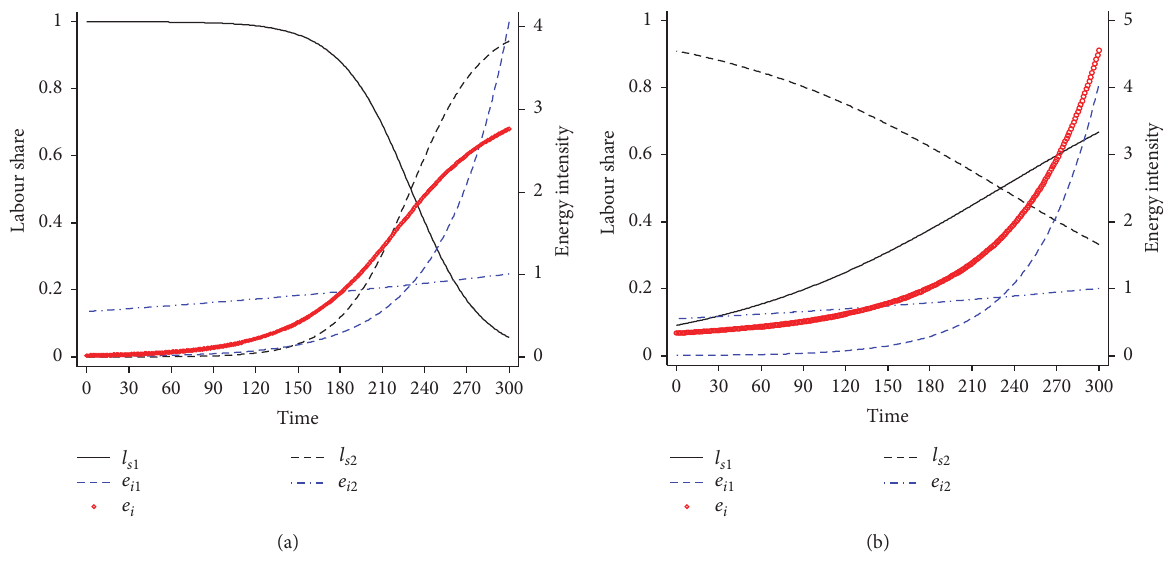
Figure 1: Increasing trend of economy-wide energy intensity with high energy technological growth rate, (a) 𝜀 = 3 and (b) 𝜀 = 0.5 .